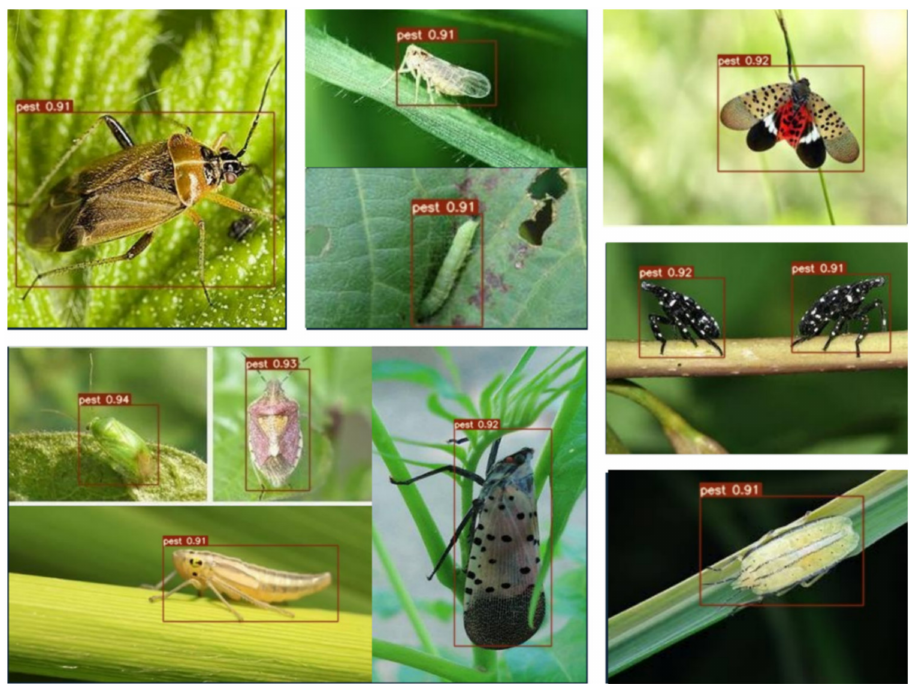
Figure 11. Detection accuracy of improved YOLOv5m for different insect pest images in real environ- mental scenarios such as field and